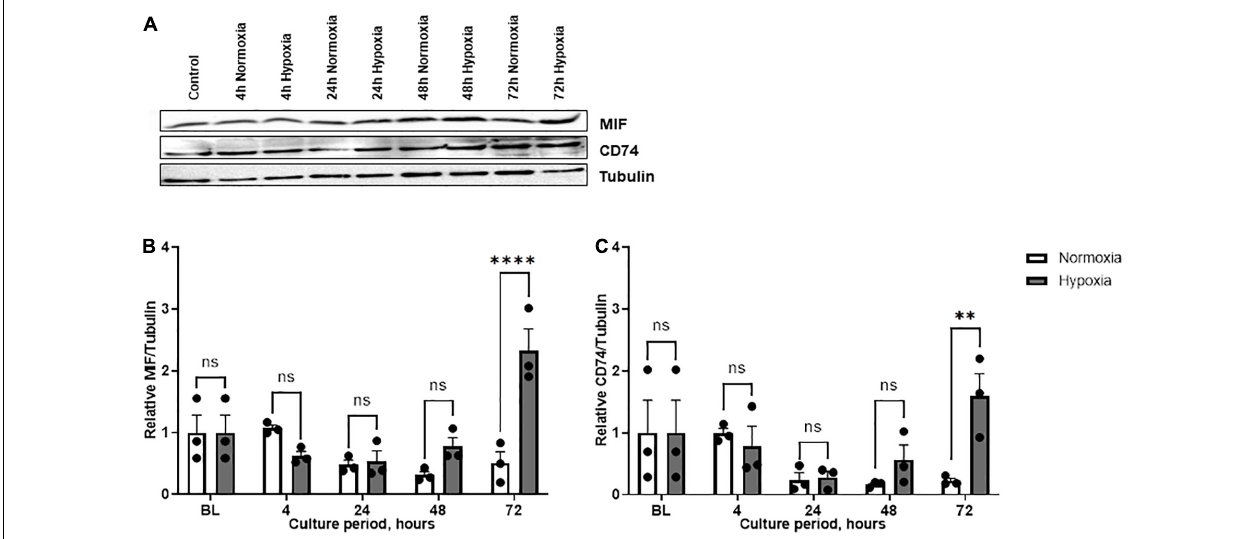
FIGURE 4 | Expression levels of MIF and CD74 under normoxia and hypoxia in patient group B. Group B included three adipose tissue specimens from chronic non-healing wounds, which exhibited high MIF secretion in the hypoxic culture of ASCs. Cells were cultured in growth medium at normoxic oxygen levels of 21% O 2 or hypoxic oxygen levels of < 1% O 2 . Cell lysates were obtained at indicated measuring points. Western blot analysis was performed and evaluated using the AIDA software. Tubulin was detected for total protein standardization. (A) Blots are representative of all Western blots performed to detect levels of MIF, CD74, and tubulin. Analyses were performed for three biological replicates, respectively ( n = 3). The graphs display (B) relative MIF/tubulin and (C) relative CD74/tubulin normalized to the baseline value (BL) at 0 h, set to one. Data are mean values ± SEM (two-way ANOVA, Holm-Šídák’s multiple comparisons test, ∗∗ p < 0.01, ∗∗∗∗ p < 0.0001).